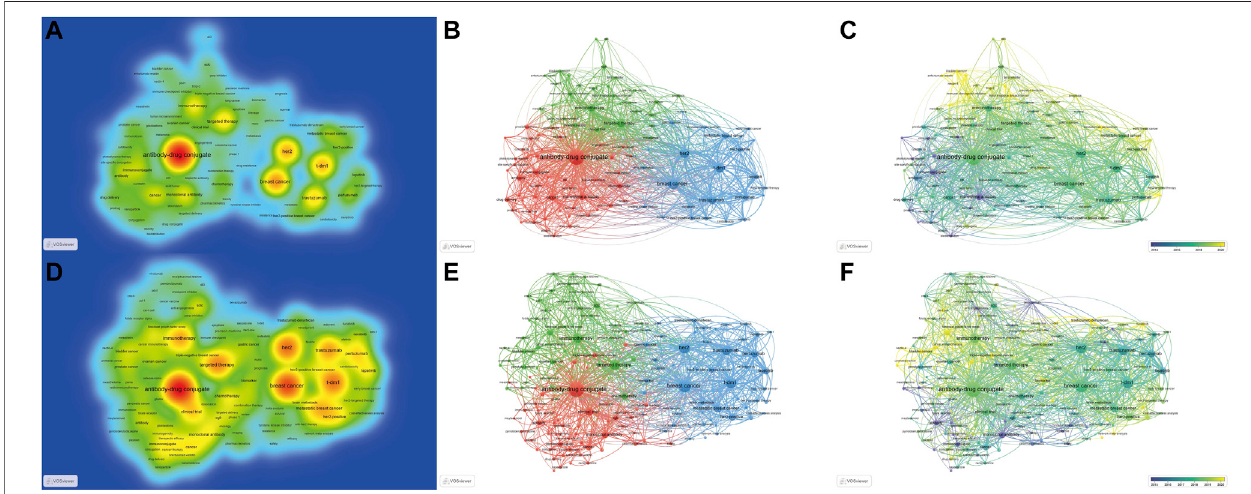
FIGURE 6 | The density, co-occurrence, and overlay map of keywords. (The density, co-occurrence, and overlay map are displayed in the fi rst to third columns, respectively.) (A – C) . Maps for the holistic ADC research fi eld. (D – F) . Maps for the clinical ADC research fi eld.